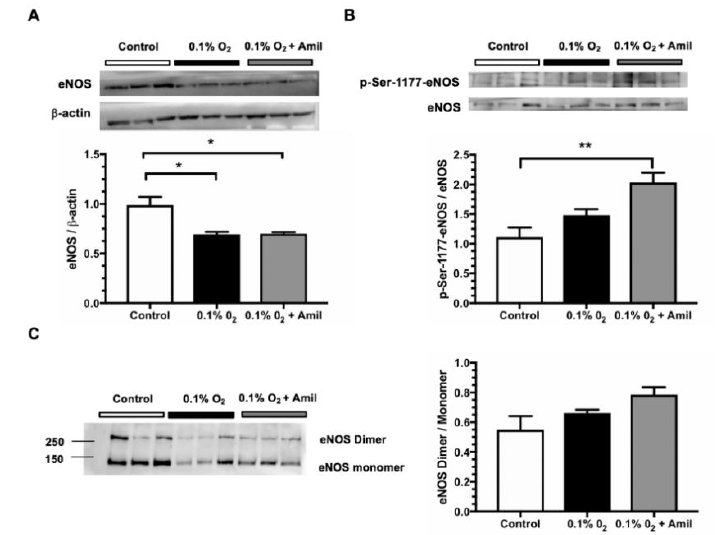
Figure 5. E ff ect of ENaC inhibition in human endothelial cells (HMEC-1) on eNOS activation after hypoxia / reoxygenation . HMEC-1 cells were incubated in normal oxygen concentration (21%) (control) or in hypoxic conditions (0.1% O 2 ) with or without amiloride 1 µ M addition for 24 h. The cells were returned to normal oxygen for 4 h reoxygenation and the proteins were extracted. ( A ) eNOS protein levels and ( B ) eNOS phosphorylation at Ser1177 determined by Western blot. ( C ) The dimer / monomer ratio of eNOS was determined in low-temperature / low-voltage SDS electrophoresis and Western blot. n = 3 per group, each lane represents an independent experiment for each condition. * p < 0.05 and ** p < 0.01.